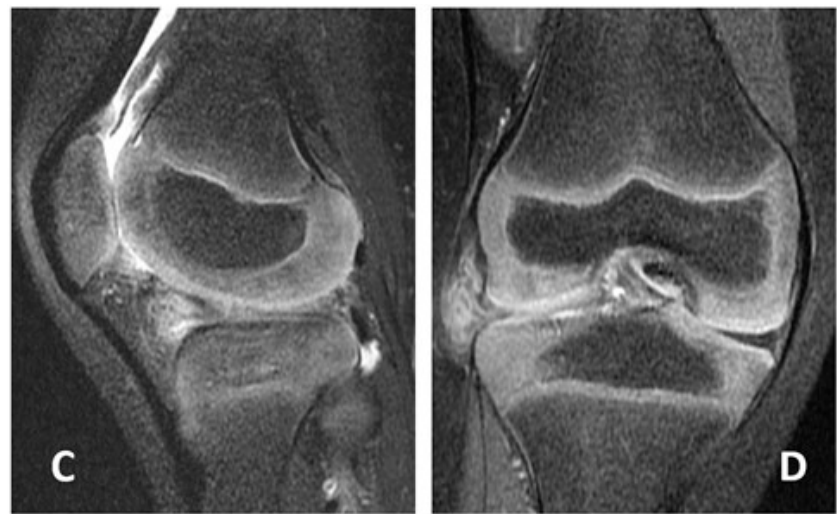
Figure 3. MRI of the affected knees for the two cases at the 6-month follow-up. ( A ) coronal and ( B ) sagittal planes for the case of the 28-month girl. ( C ) coronal and ( D ) sagittal planes for the case of the 5-year-old boy. A triangular lateral meniscus without a retear was found in both cases. MRI—magnetic resonance imaging.